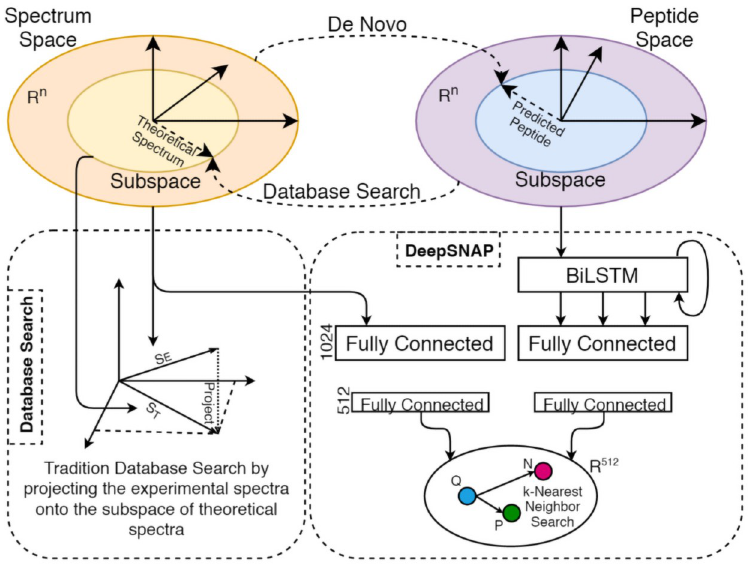
Fig 3. Space transition methods. De novo and database search, that try to transform one space to another. This is prone to error and uncertainty as a lot of information can be missed. On the contrary, SpeCollate learns same sized embeddings for both peptides and spectra by projecting them to a shared euclidean